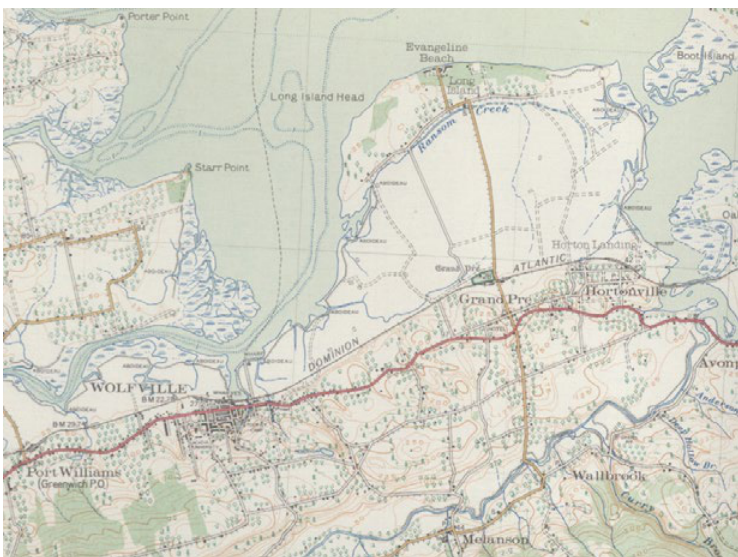
Figure 1 Canada, Surveys and Mapping Branch, Department of Energy, Mines and Resources, National Topographic Survey: Wolfville, Nova Scotia (1928),